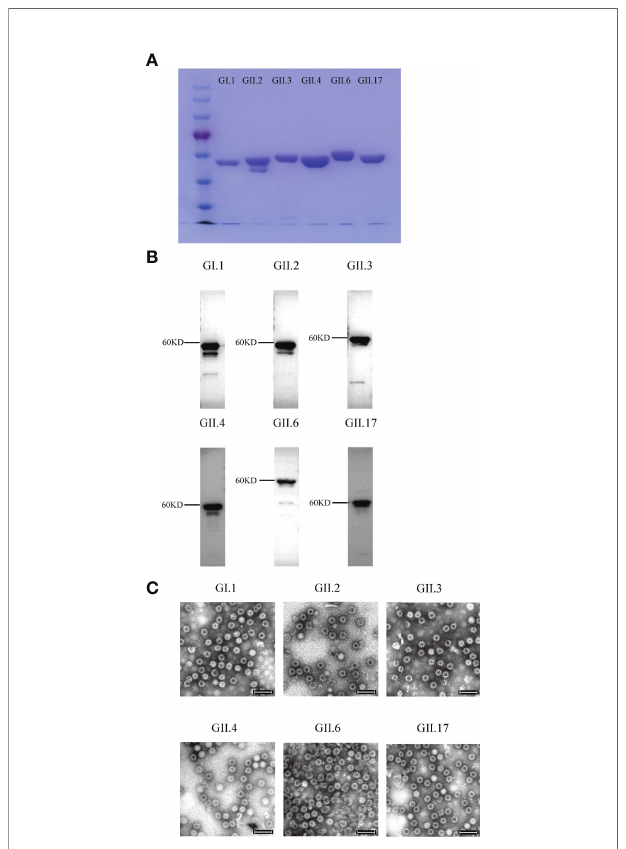
FIGURE 1 | SDS-PAGE, Western blot, and electron microscopy images of the puri fi ed norovirus (NoV) virus-like particles (VLPs). (A) SDS-PAGE imaging. (B) Western blot imaging. (C) GI.1, GII.2, GII.3, GII.4, GII.6 and GII.17 VLPs. VLPs were subjected to negative staining with 2% phosphotungstic acid, transmission electron microscopy was performed (Hitachi HT7700 transmission electron microscope, Japan) at 80 kV. Bar = 100